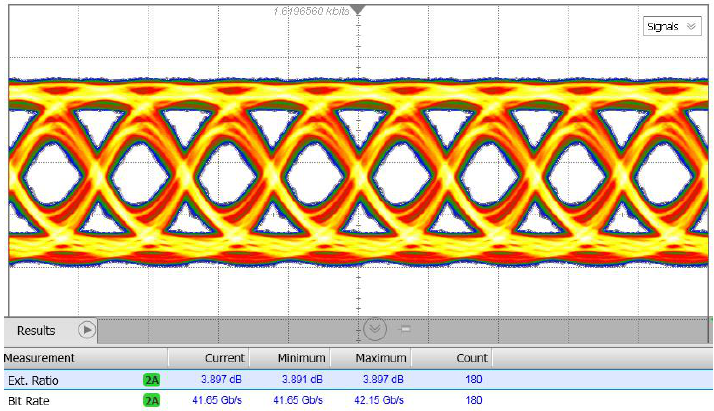
Figure 7. Measured 40 Gb / s optical eye-diagram of a Si photonic carrier depletion modulator.